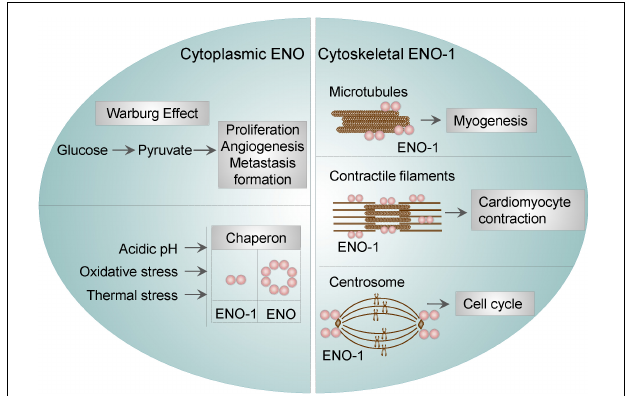
FIGURE 1 | Cytosolic and cytoskeletal functions of ENO-1. Cytosolic ENO-1 is the main enzyme contributing to the glycolysis and its tumor adaptation Warburg effect. In addition, cytoplasmic ENO may function as a chaperone in bacteria and mammalian cells (eukaryotic ENO-1 is presented as a dimer, whereas bacterial ENO is an octamer). Furthermore, ENO-1 can interact with (i) microtubules during the process of myogenesis (ii) contractile filaments of cardiomyocytes upon their contraction and (iii) centrosome during the cell